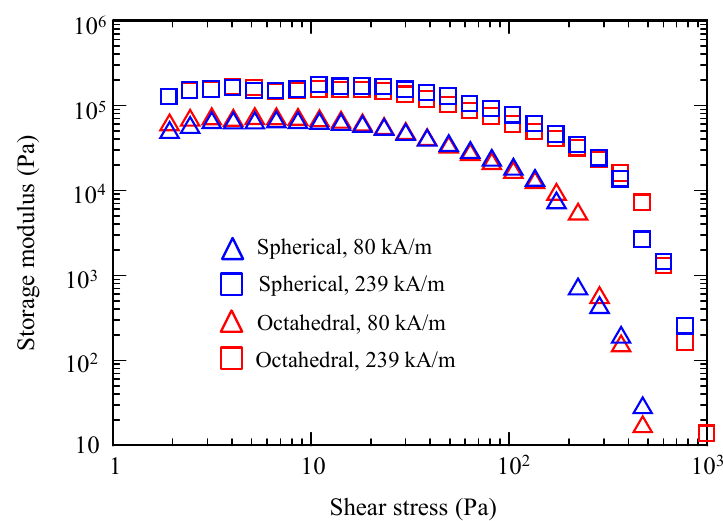
Figure 7. Storage modulus as a function of the shear stress amplitude, for the spherical-based and the octahedral-based suspensions.